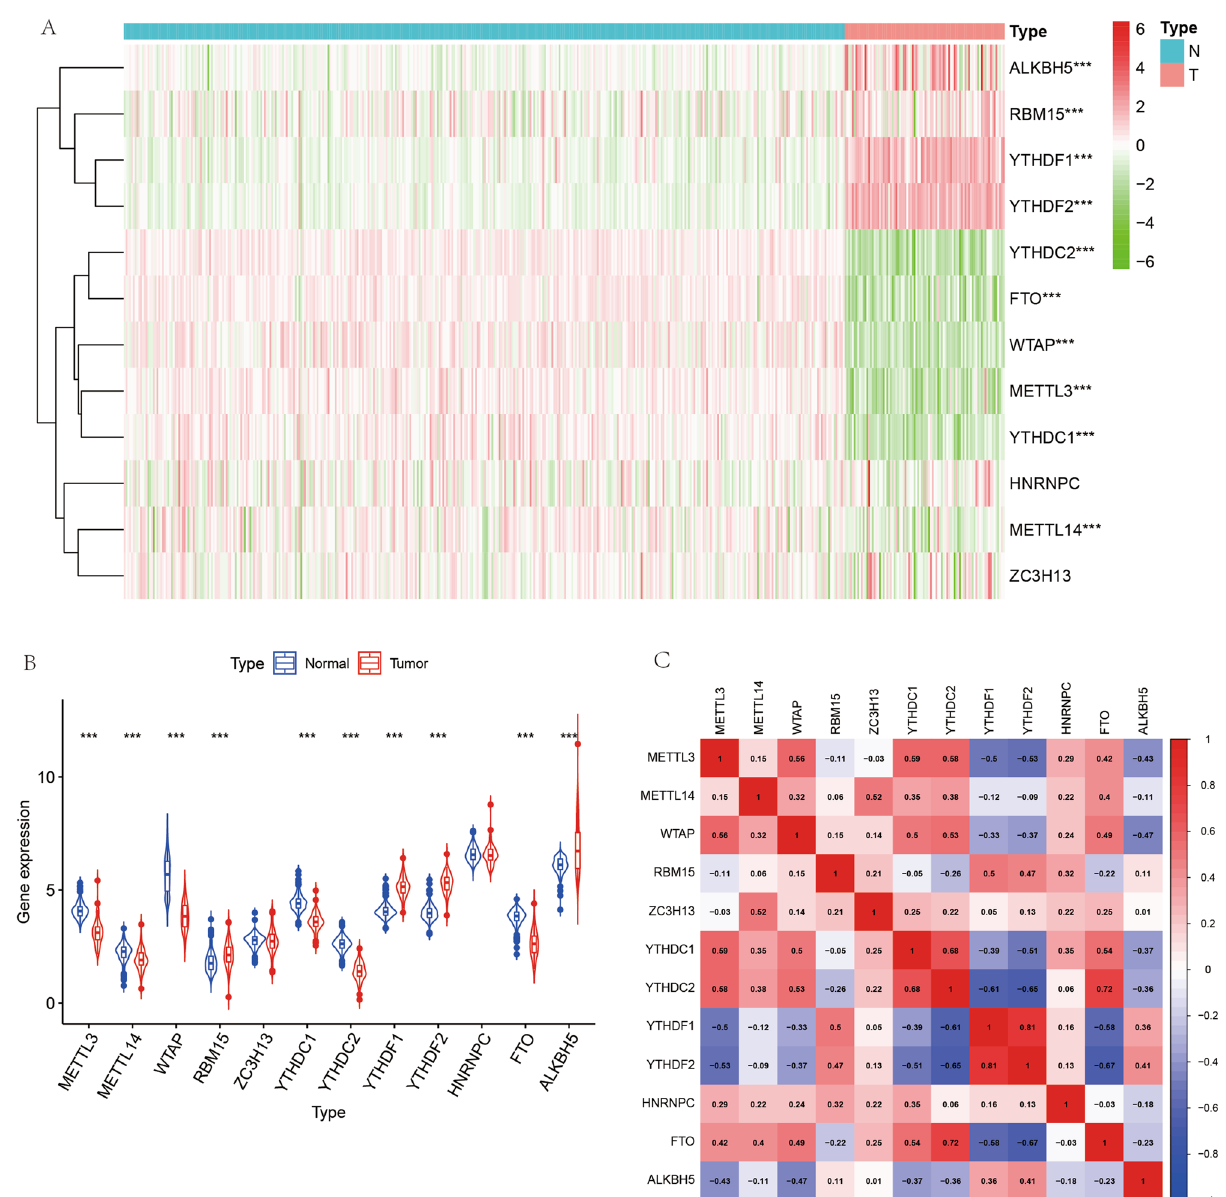
Figure 2. M6A-related genes differential analysis and correlation analysis plots. ( A ) Shows the heat map of m6A-related genes, red indicates high expression and green indicates low expression. "***" indicates P < 0.001. ( B ) Indicates the difference in expression of m6A-related genes in osteosarcoma and paraneoplastic tissues. ( C ) Indicates the correlation analysis graph between m6A-related